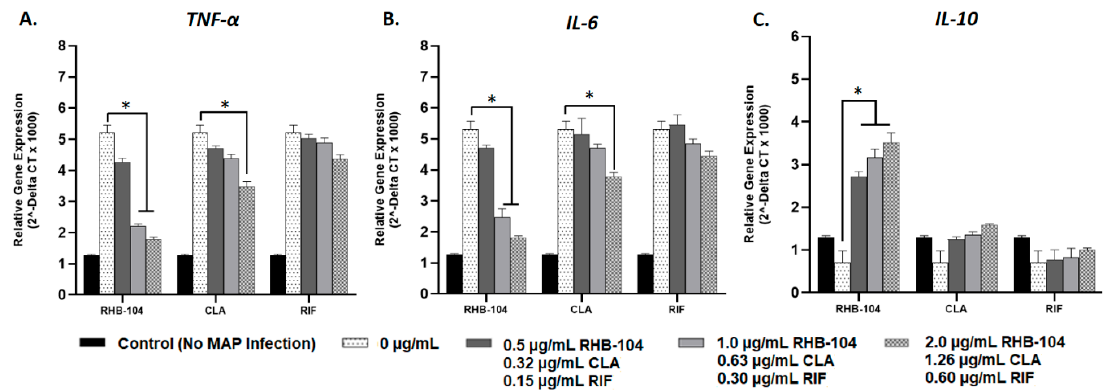
Figure 4. Effect of RHB-104 and its major components on TNF- α , IL-6 , and IL-10 expression in MAP-infected macrophages. RT-PCR measurements of expression of TNF- α ( A ), IL-6 ( B ), and IL-10 ( C ) in MAP-infected macrophages (24 h) followed by treatment with RHB-104 (0, 0.5, 1.0, 2.0 µ g / mL), CLA (0, 0.32, 0.63, and 1.26 µ g / mL), and RIF (0, 0.15, 0.30, 0.60 µ g / mL) for 24 h. * p <